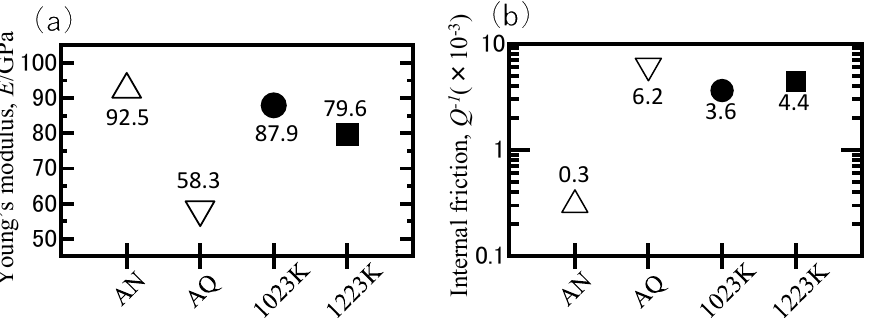
Figure 6. Change in material properties after each heat treatment. ( a ) Young’s modulus E . ( b ) Internal friction Q − 1 .